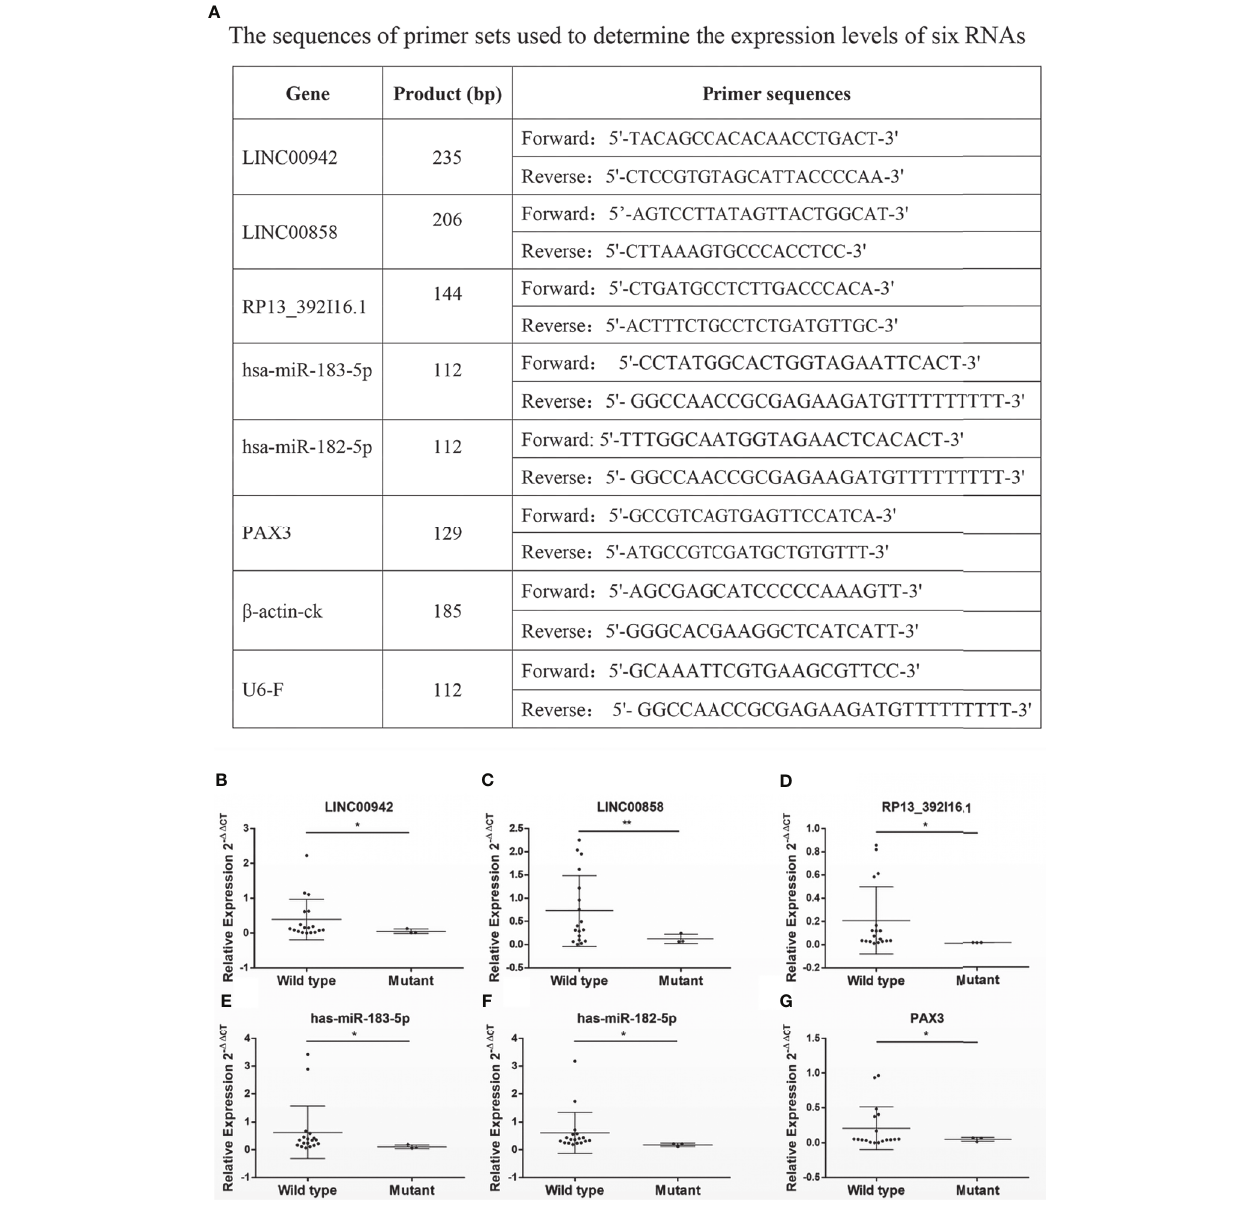
FIGURE 5 | The survival-related RNAs detected in databases are veri fi ed with external clinical samples. (A – G) A list of primers used to determine (A) and scatter diagrams showing (B – G) the expression levels of survival-related RNAs LINC00942 (B) , LINC00858 (C) , RP13.392I16.1 (D) , hsa-miR-183-5p, hsa-miR-182-5p (F) , and PAX3 (G) as detected by qRT-PCR in 21 clinical patients (wild-type n = 18 and mutant n = 3). *p < 0.05, *p <